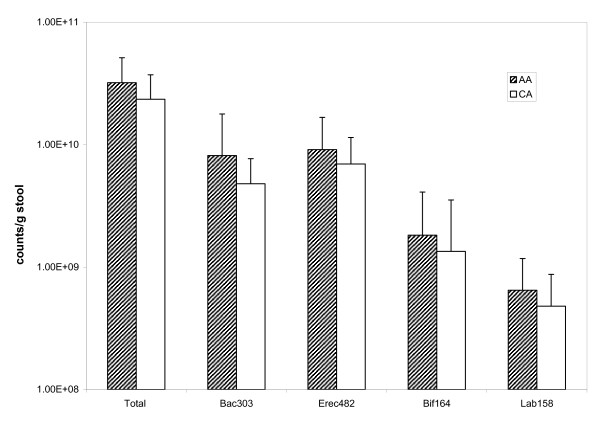
Comparison of microbiota between AA and CA. Fixed stool samples were hybridized with probes directed against Bacteroidetes (Bac 303), Clostridium Cluster XIVa (Erec482), Bifidobacteria (Bif164) and Lactic Acid bacteria (Lab158) and enumerated by FISH as described in Materials and Methods. Total bacterial counts were determined using DAPI.